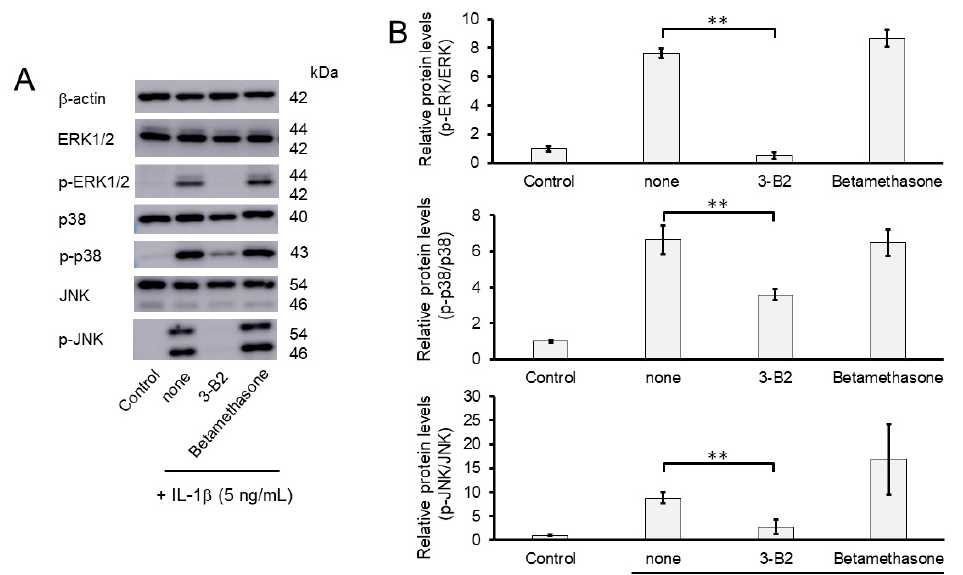
Figure 9. Effect of 3-B2 and betamethasone on the phosphorylation of Erk1/2, p38, and JNK in IL-1 β -stimulated OUMS27 cells. ( A ) Western blot analysis of the relative phosphorylation levels of Erk1/2, p38, and JNK after 3-B2 or betamethasone treatment. Cells were treated with 10 ng/mL of 3-B2 or betamethasone for 24 h and then induced with 5 ng/mL IL-1 β for 20 min. Treatment with 3-B2 but not betamethasone significantly reduced the phosphorylation of Erk1/2, p38, and JNK. ( B ) Quantitative estimation of the relative phosphorylated protein levels of Erk1/2, p38, and JNK after 3-B2 or betamethasone treatment. Values represent mean ± SE ( n = 3 per group). ** p < 0.01.